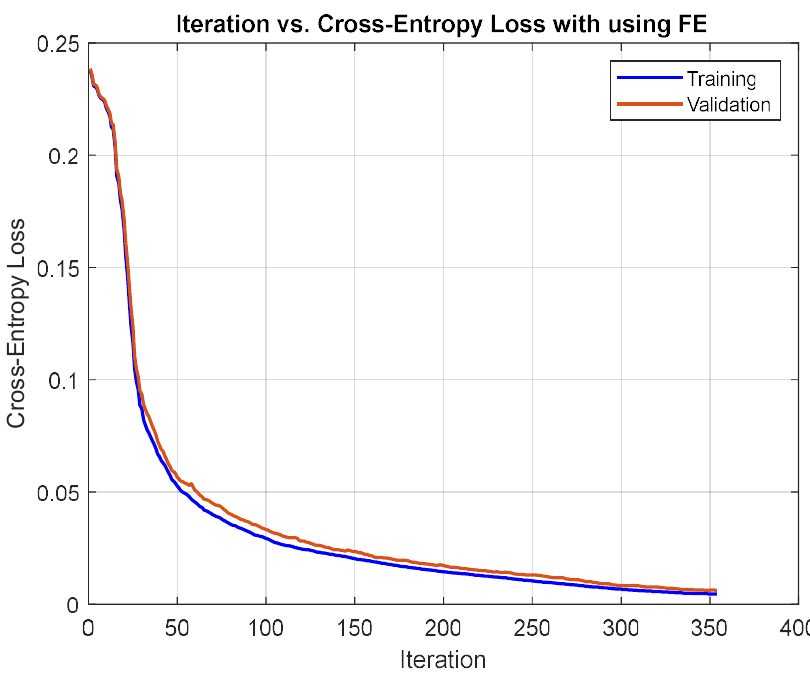
Figure 2. Iteration vs. cross-entropy loss for features extraction of noisy signals with length 6400, one hidden layer with ten nodes for DNN.